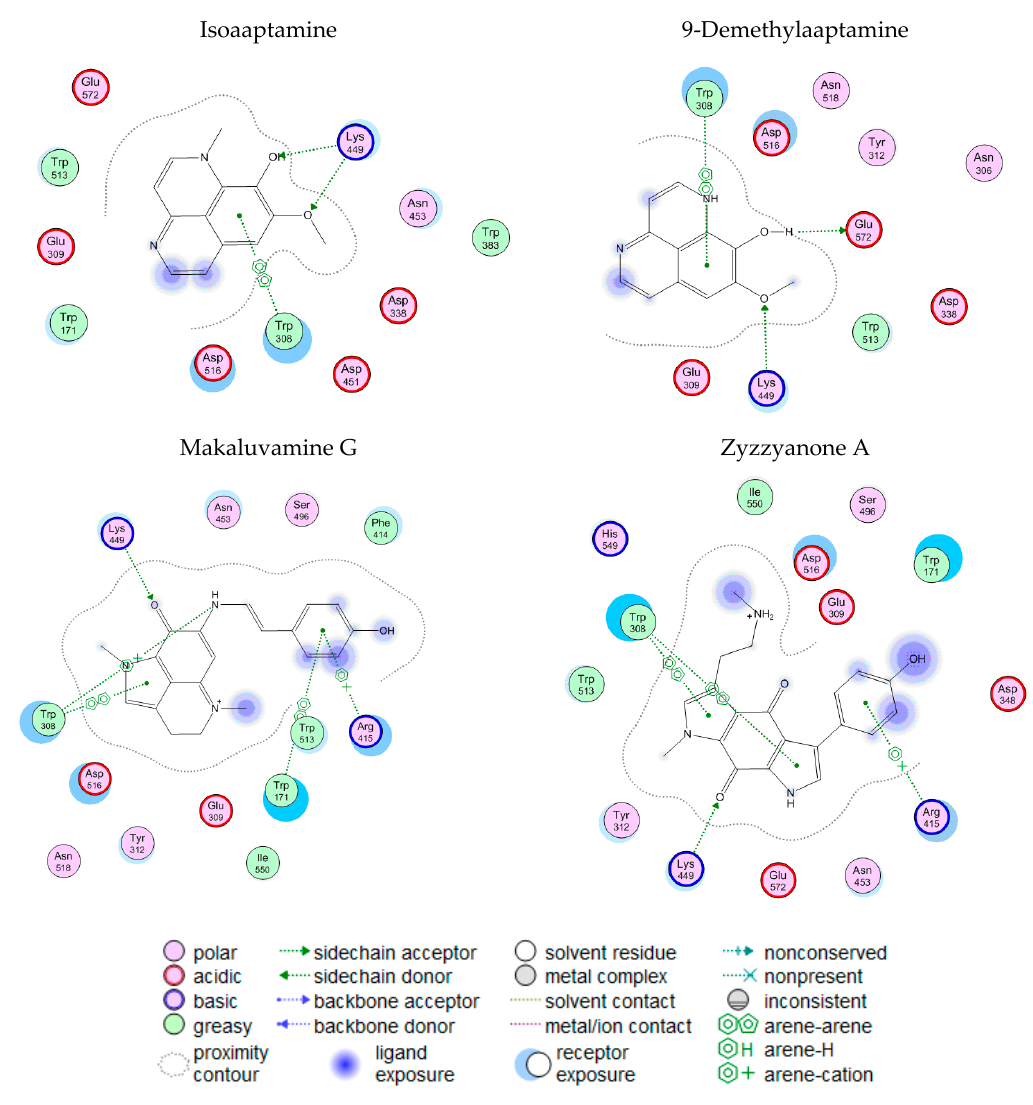
Figure 3. 2D-diagrams of the α -PsGal complexes with alkaloids of aaptamine and makaluvamine classes.